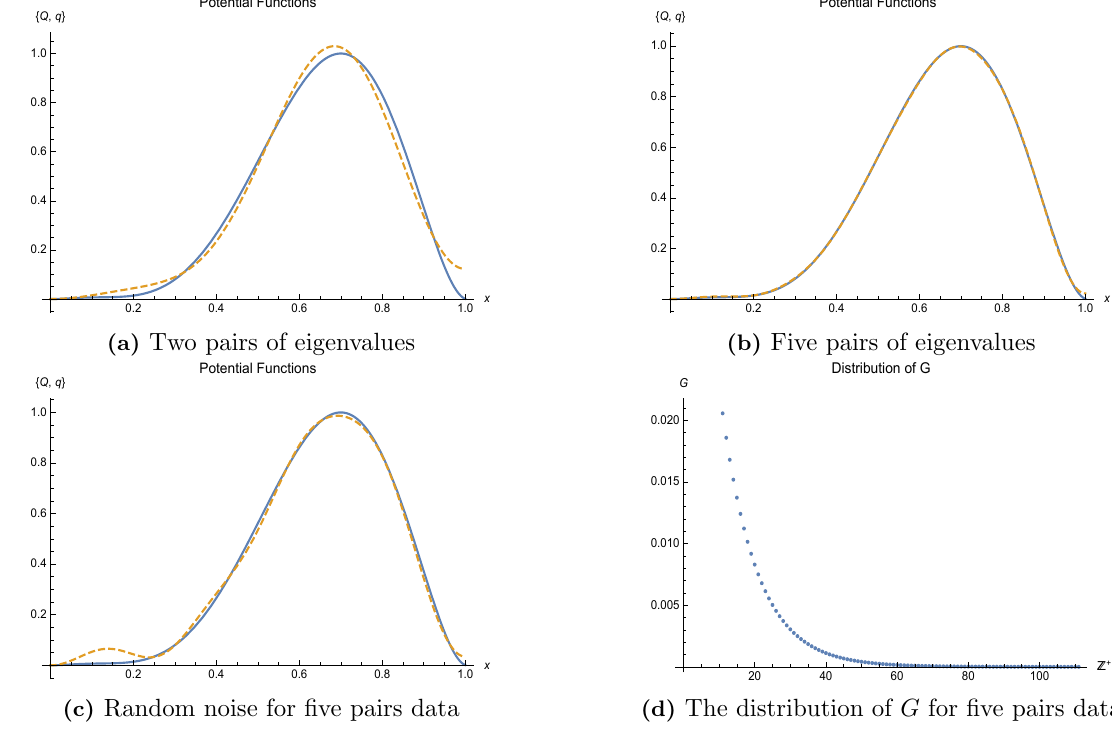
Figure 1. The graphics (a), (b), and (c) show the numerical results for Q 1 ( x ). The graphic (d) shows the distribution of G ( q ) for Q 1 ( x ).